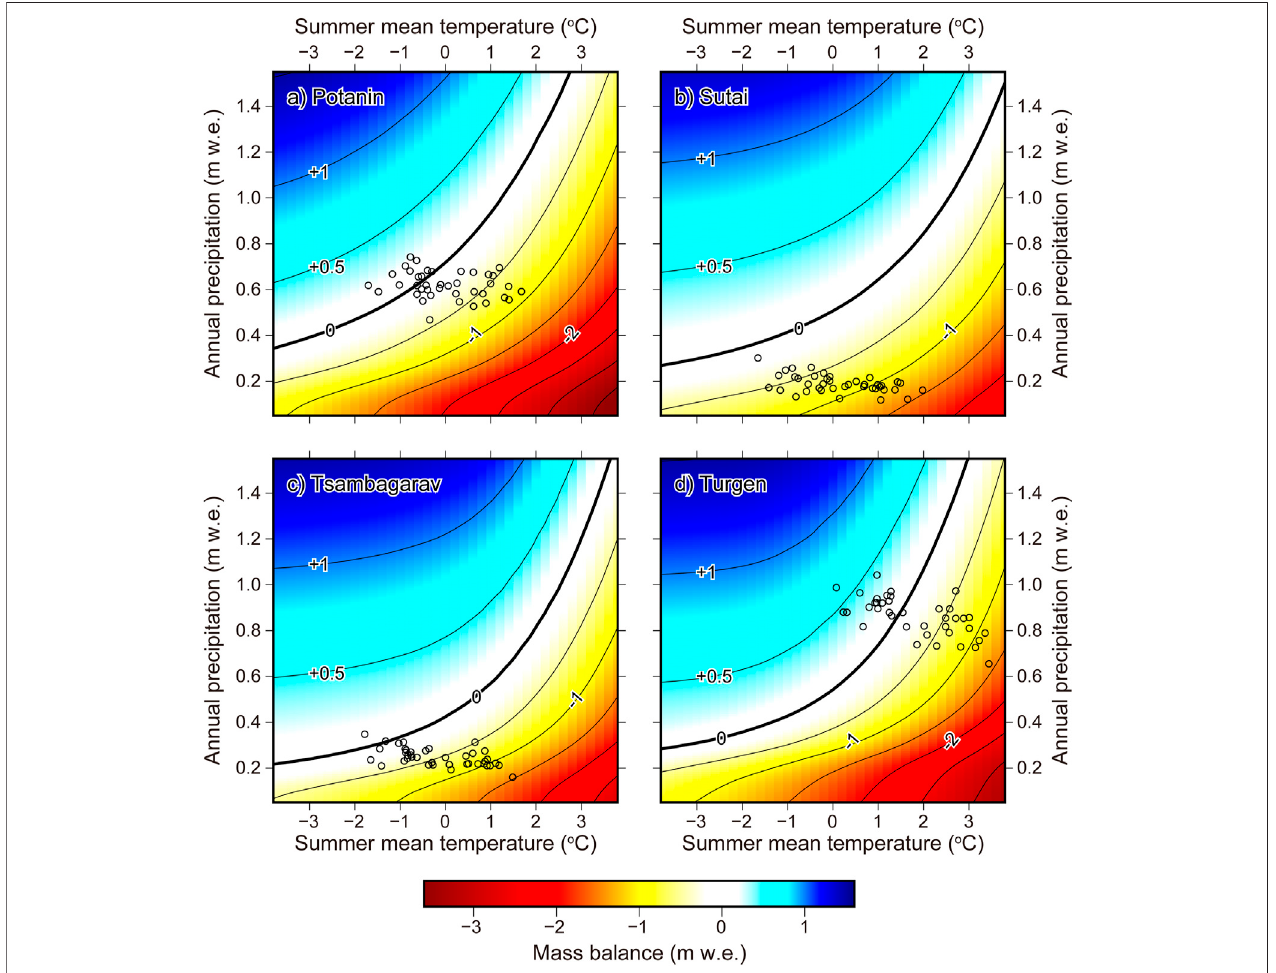
FIGURE 9 | Climatic regime for the present-day geometry of (A) Potanin, (B) Sutai, (C) Tsambagarav and (D) Turgen glaciers for different summer mean air temperature (horizontal axes) and annual precipitation (vertical axes) combinations. Black open circles denote the long-term regime that wasderived from the calibrated ERA5 data for the 1980 – 2018 period (39 years). Contour lines denote the glacier-wide mass balances in 0.5 m w. e. increments.